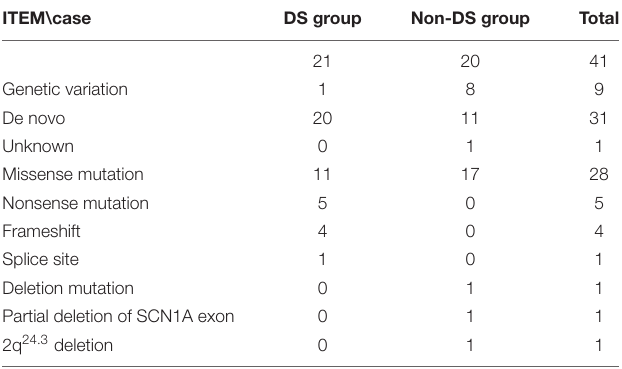
TABLE 4 | Summary of 41 patients’ genetic data.